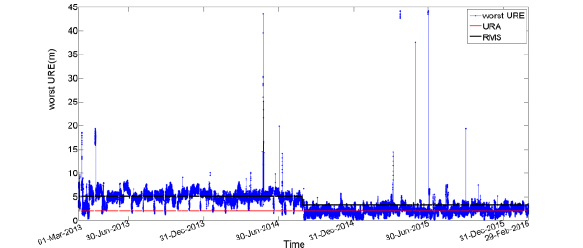
Figure 4 Absolute values of Worst URE of Satellite